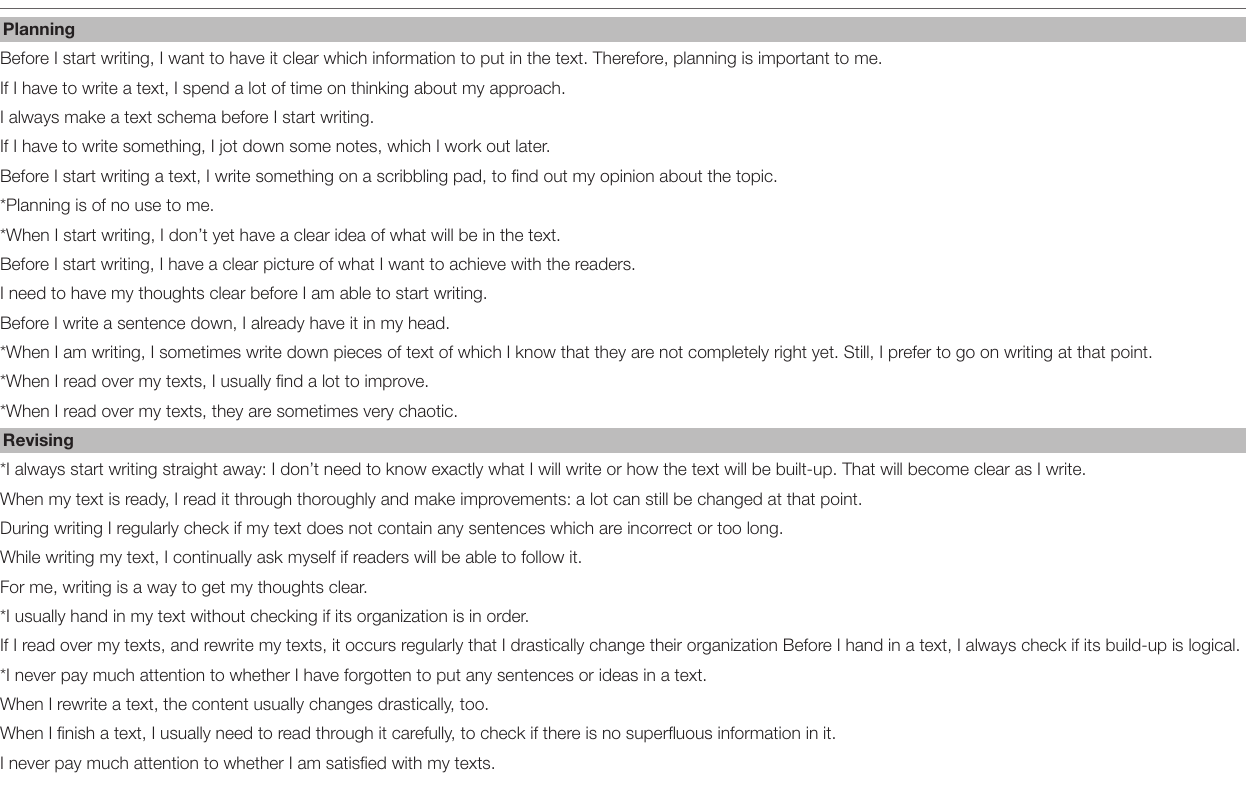
TABLE A1 | Items in the Writing Style Questionnaire (Kieft et al., 2006, 2008), sorted according to which dimension they measure.